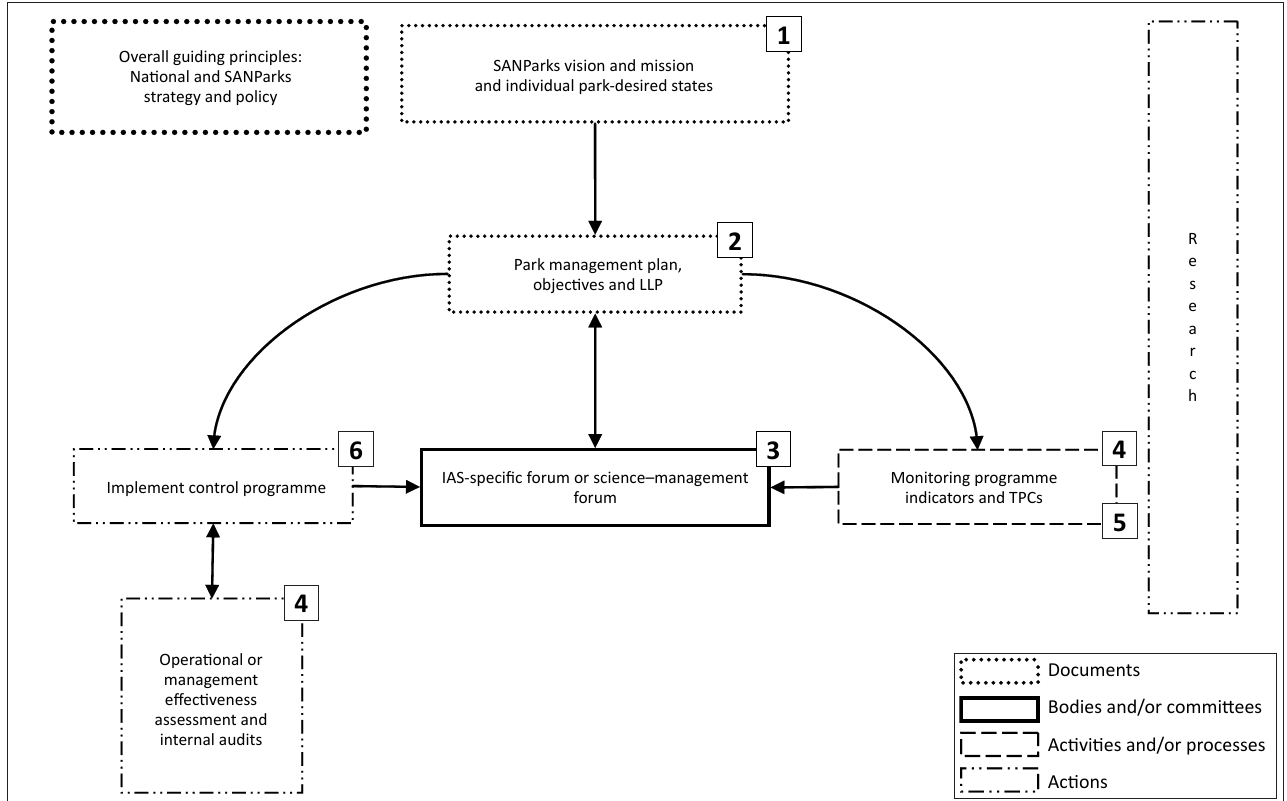
FIGURE 2: An overview of the adaptive management process for an overall invasive alien species management framework. Each number in the figure is related to the specific point in the ensuing discussion. The monitoring programme (number 4) is further expanded on in Figure 3. managers and regional ecologists and also receives input from specialist researchers where needed. The